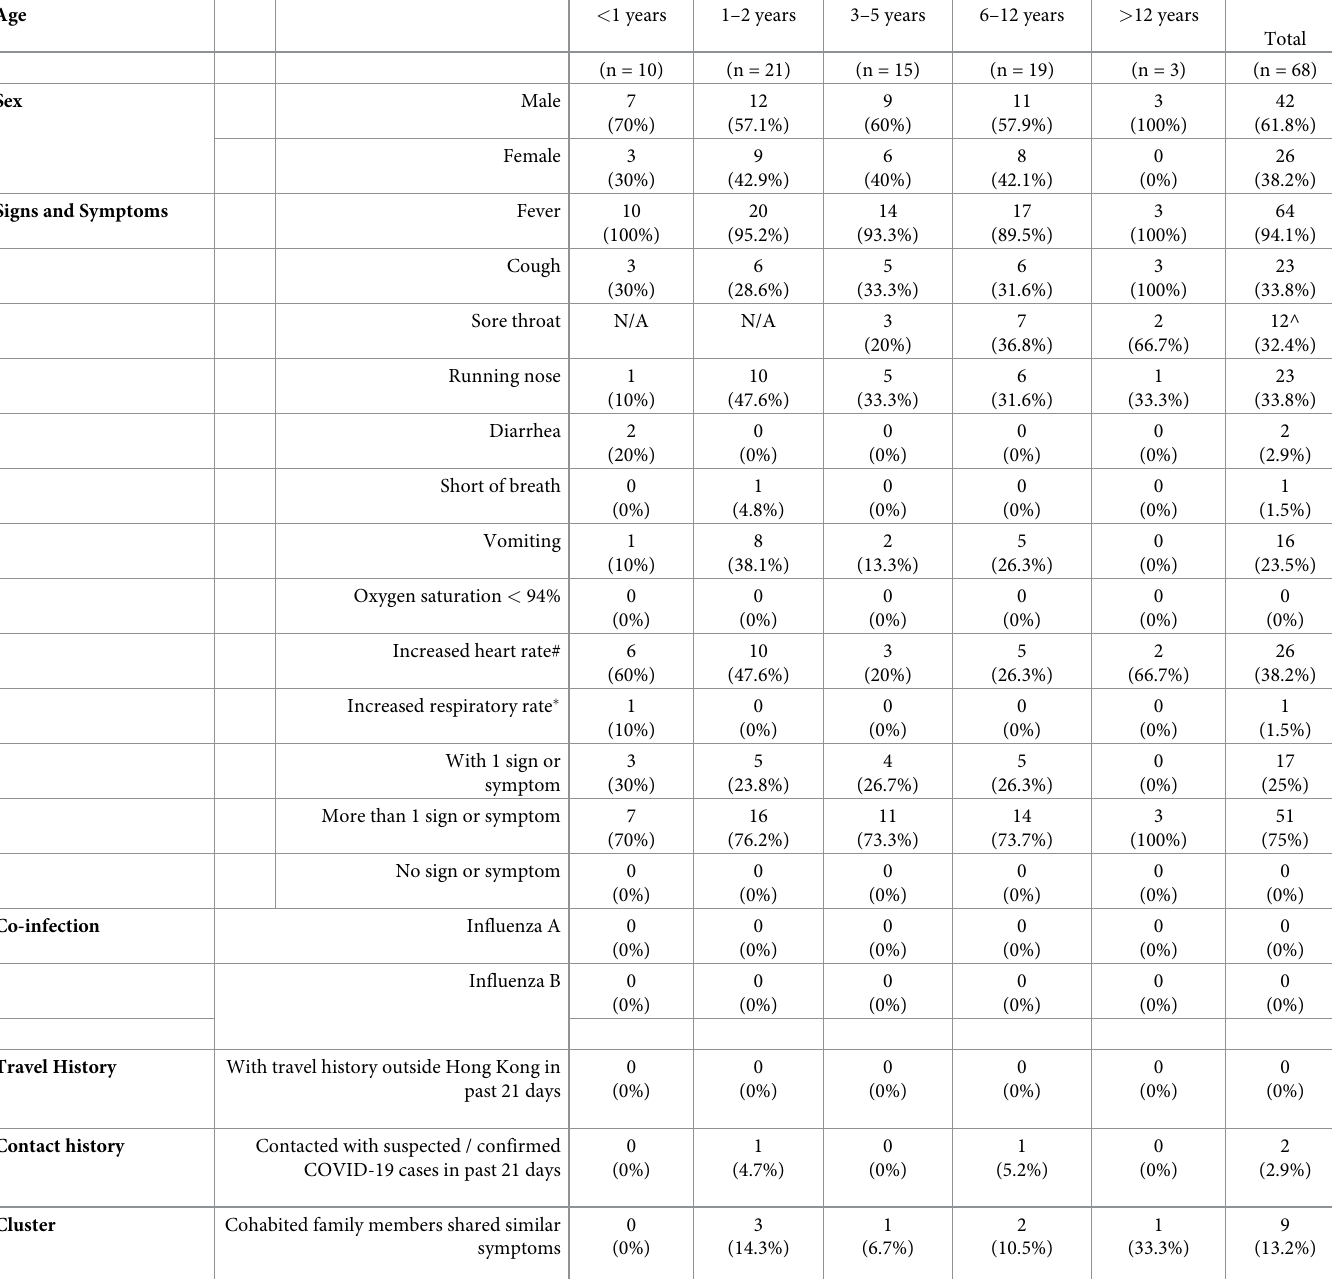
Table 1. Clinical characteristics and demographics of the SARS-CoV-2 infected pediatric patients (n = 68) aged between 0 and 17 years.